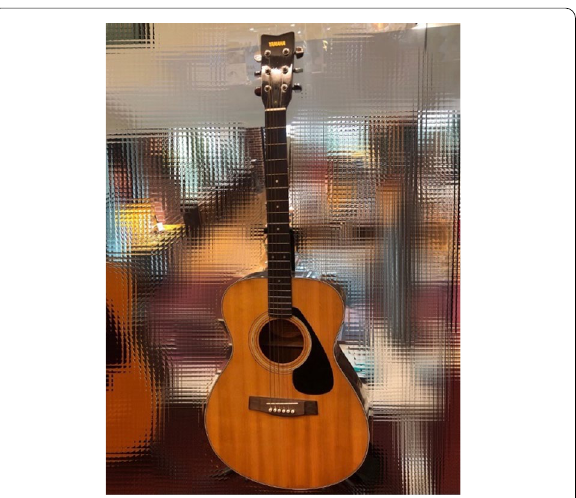
Fig. 1 Example of a Martin guitar (D-28,146 samples in analysis). Photograph taken with permission of store